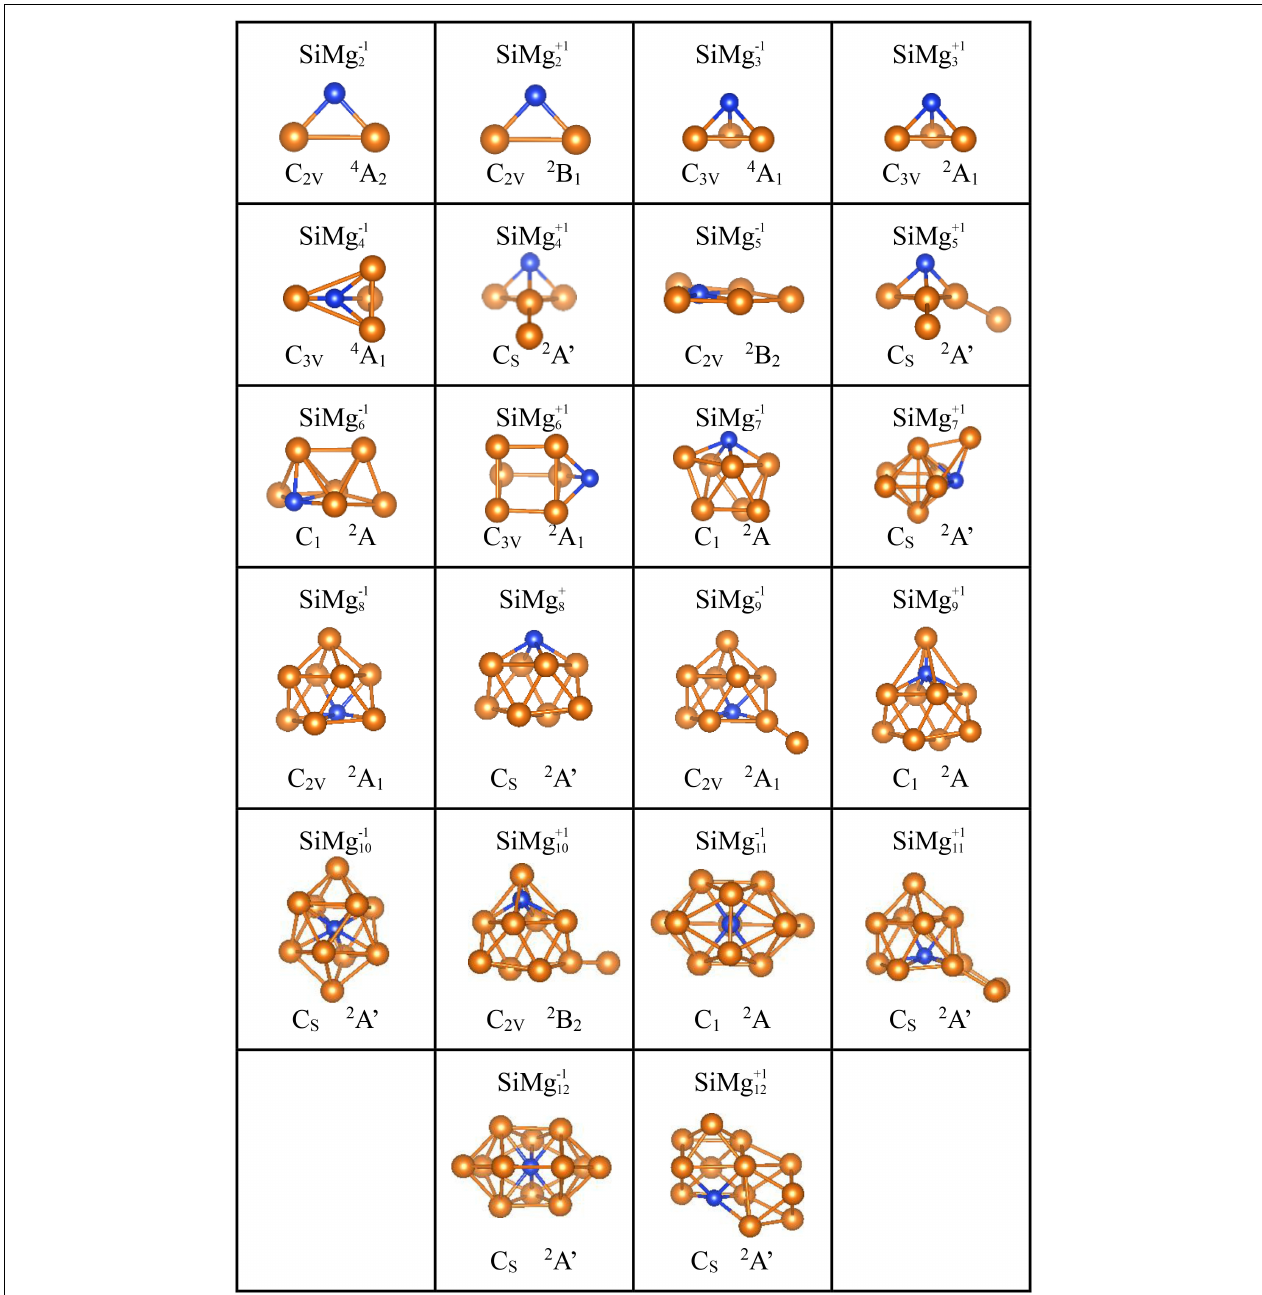
FIGURE 2 | Optimized geometrical structures of ground state of SiMg ± 1 n ( n = 2–12) clusters at B3LYP /6-311+G(d) level. The yellow and blue balls are magnesium and silicon atoms, respectively.